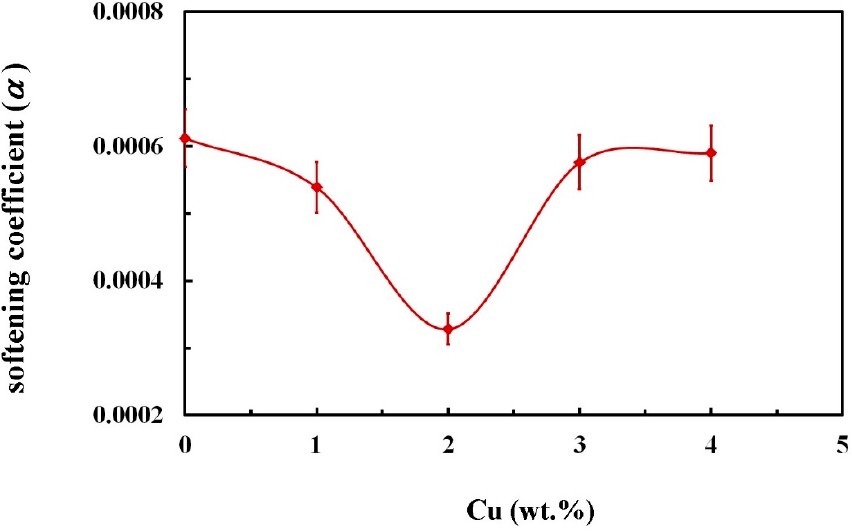
Figure 8. Variation of softening coefficient, α , with Cu concentration for all the investigated alloys. Representative XRD patterns of SZ- x Cu alloys aged 323 and 398 K are respectively shown in Figure 9a,b. All XRD charts include diffraction peaks for both β -Sn phase with the tetragonal structure according to (JCPDS card no. 04-0673) and α -Zn rich phase with the hexagonal structure at 36.8 ◦ , 43.8 ◦ , and 55.6 ◦ depending on (JCPDS card no. 01-1244). The main peaks corresponding to Cu have not been detected.